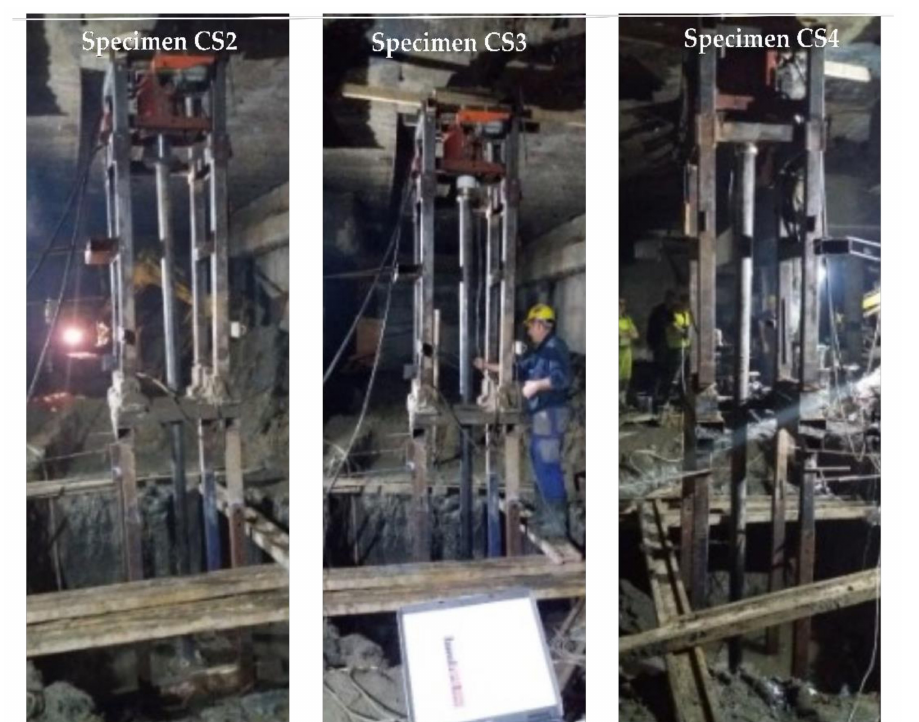
Figure 4. Testing of the specimens CS2, CS3 and